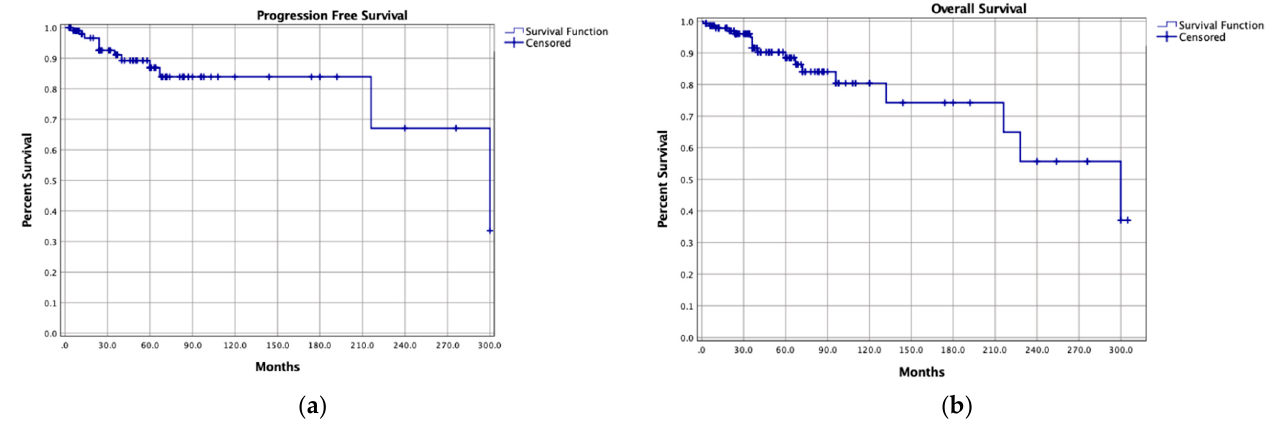
Figure 2. Kaplan-Meier curves of ( a ) progression-free survival and ( b ) overall survival of the pooled cohort.